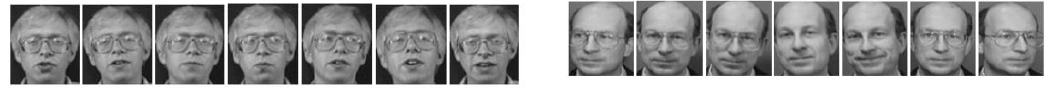
Figure 5. Some samples from the ORL (Olivetti Research Laboratory) database.